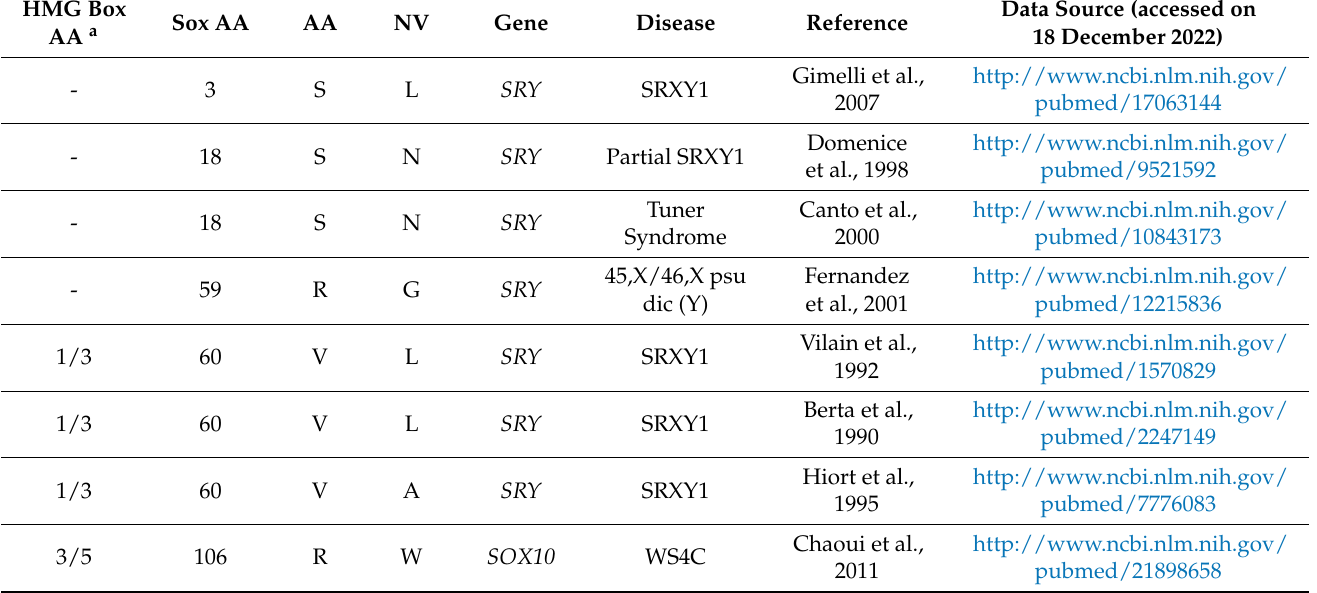
Table 1. SOX gene variants with potential functional outcomes extracted from the literature.